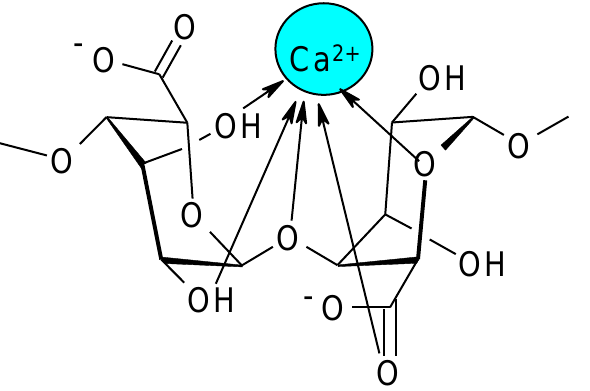
Figure 2. Probable structure of the complex formed by binding of the Ca 2+ ion with L-guluronic acid residues.